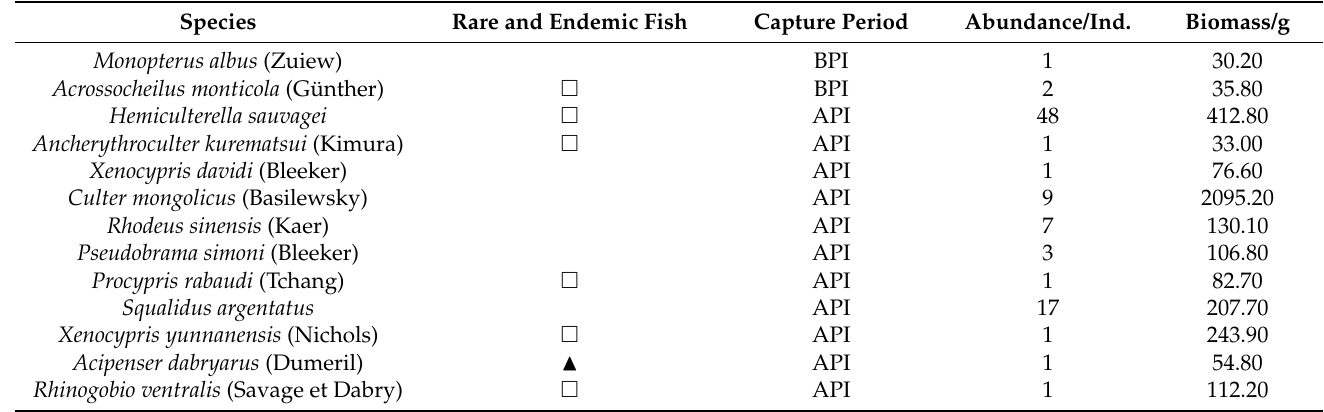
Table 1. Fish species caught only before the implementation of the project or after the project. “ (cid:3) ” indicates endemic fish; “ (cid:78) ” indicates rare fish. “BPI” is the abbreviation of “before the implemen- tation”; “API” is the abbreviation of “after project implementation”. Endemic or rare species were classified according to Cao [10].